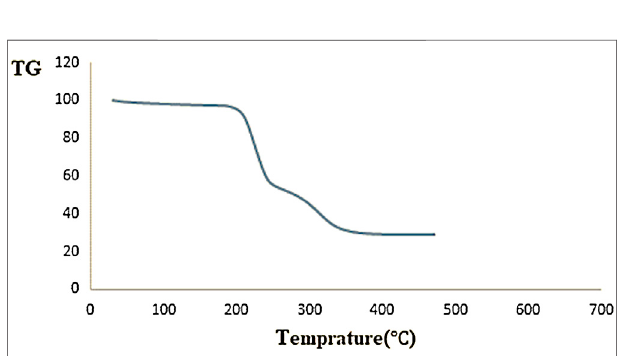
FIGURE 5 | TGA thermogram for fi brous nanostructures based on cyclodextrin.